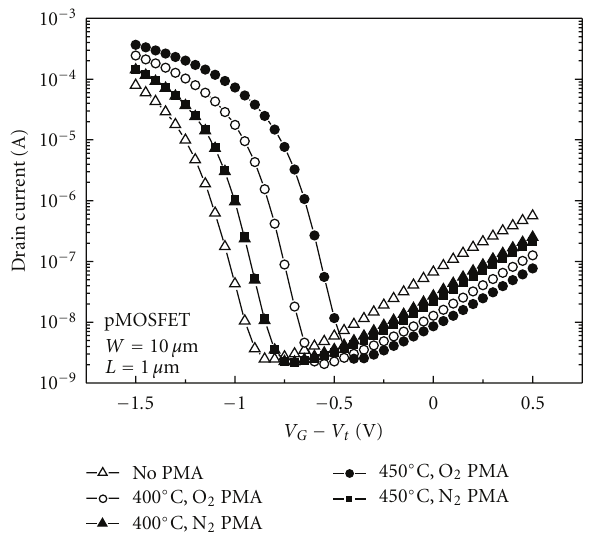
Figure 2: The C - V curves with V FB normalization.